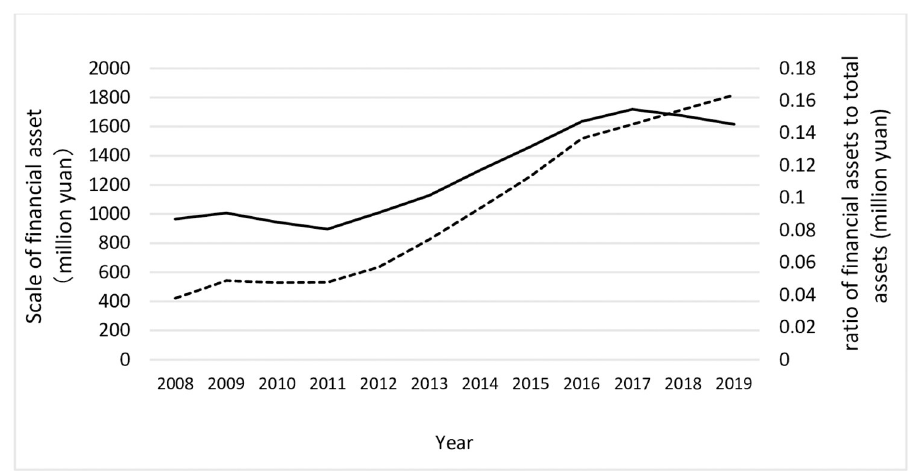
Fig 1. Scale of financial assets and ratio of financial assets to total assets of non-financial listed companies.